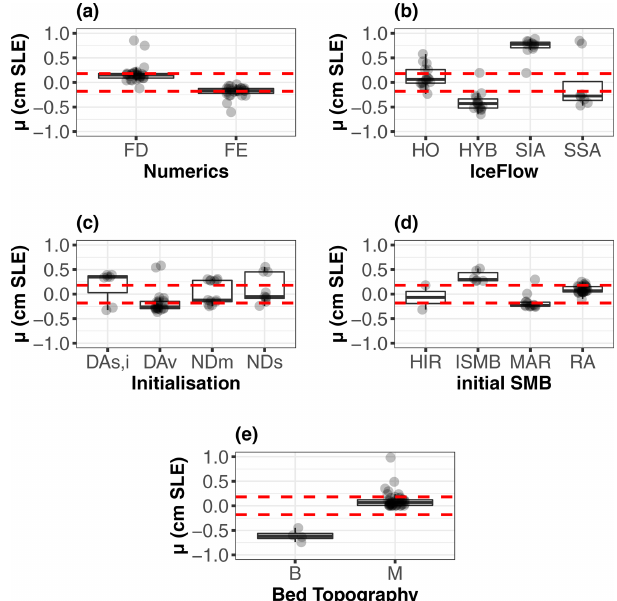
Figure 7. Application of SHAP to all members of the MIROC5 RCP8.5-forced GrIS MME for the year 2100. Each panel provides µ ( y axis) as a function of the value of the minimum and maximum grid resolution (c, d) , of the initial year (b) , and of the retreat pa- rameter κ (a) . The horizontal dashed red lines indicate the limits de- fined by ± MAE calculated from the leave-one-out cross-validation procedure: contributions falling within this range indicate that they cannot be distinguished from the predictive error.